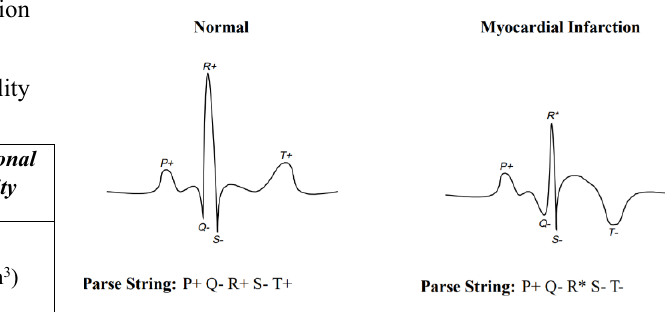
Figure 3. The classes of heartbeat